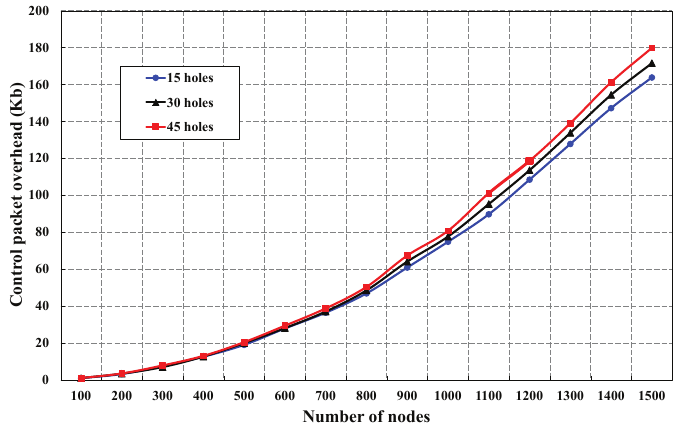
Figure 9. Control packet overhead in DCHD with different numbers of coverage holes.